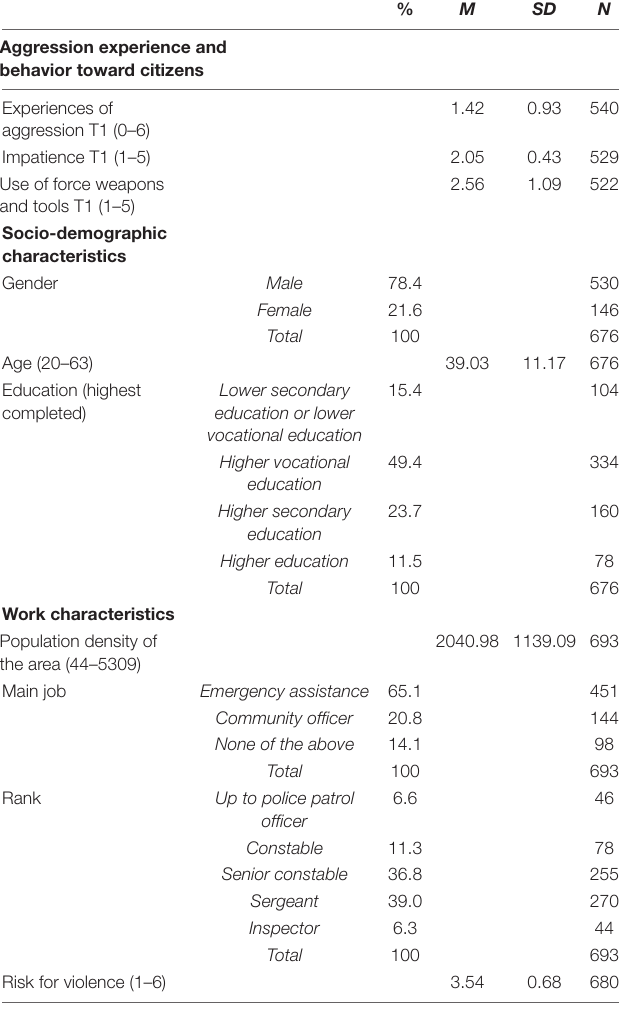
TABLE 1 | Descriptive values of variables in the